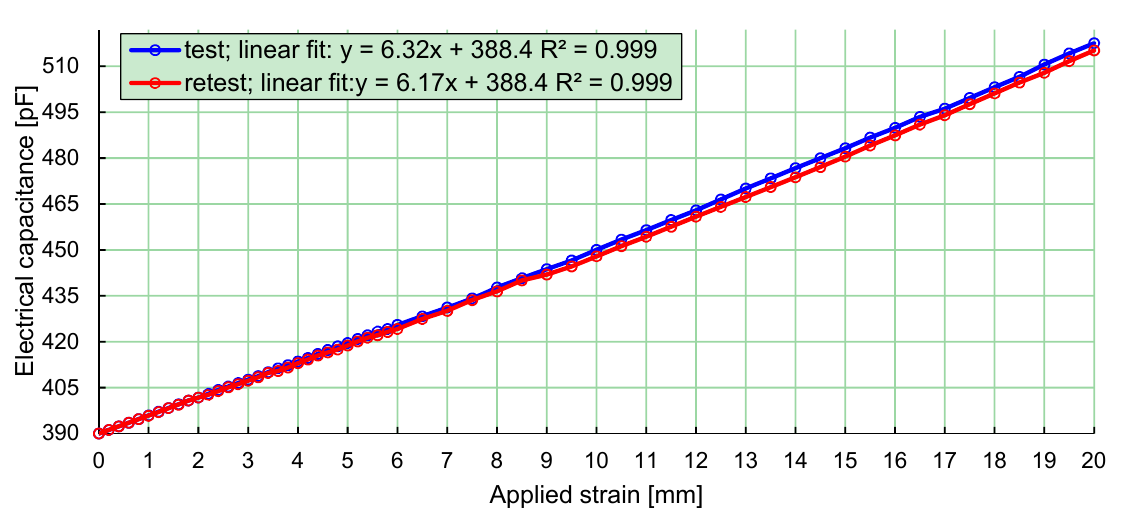
Figure 4. Relation between the measured electrical capacitance and strain of the PBS.